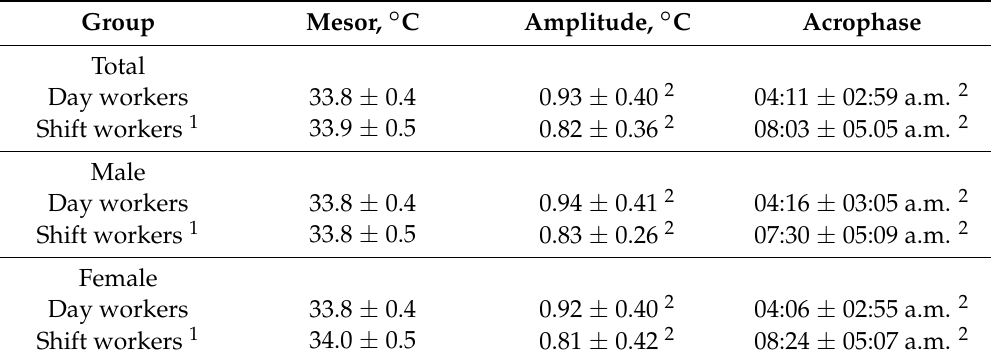
Table 2. Cosinor analysis of the wrist-skin temperature of the day and shift